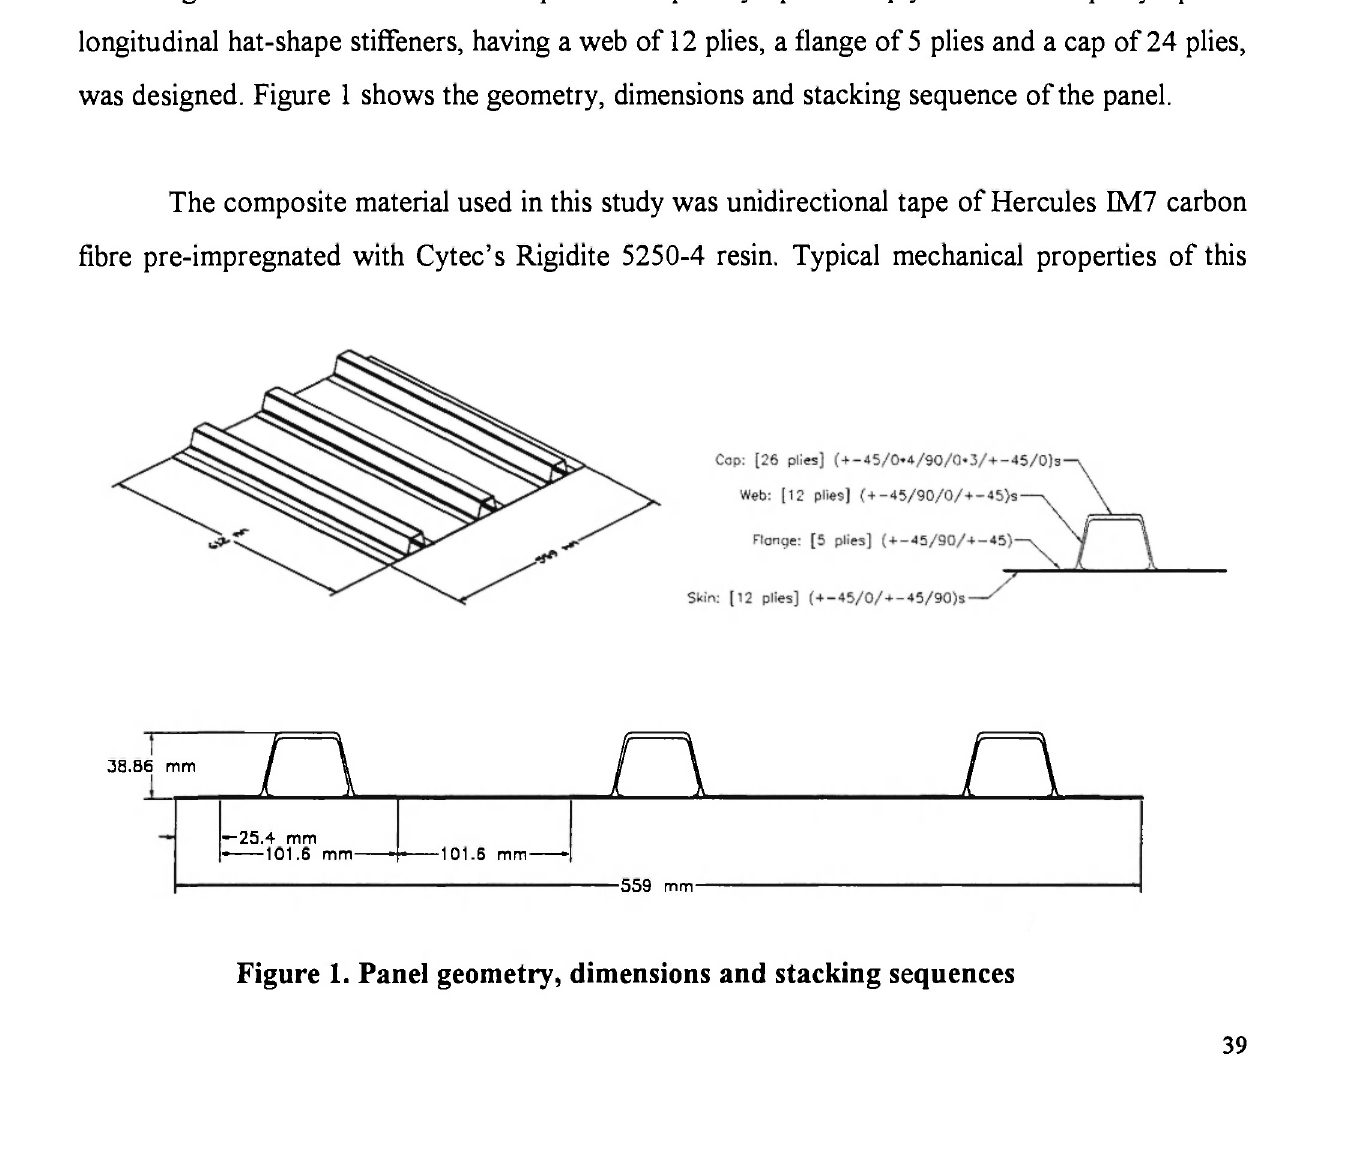
Figure 1. Panel geometry, dimensions and stacking